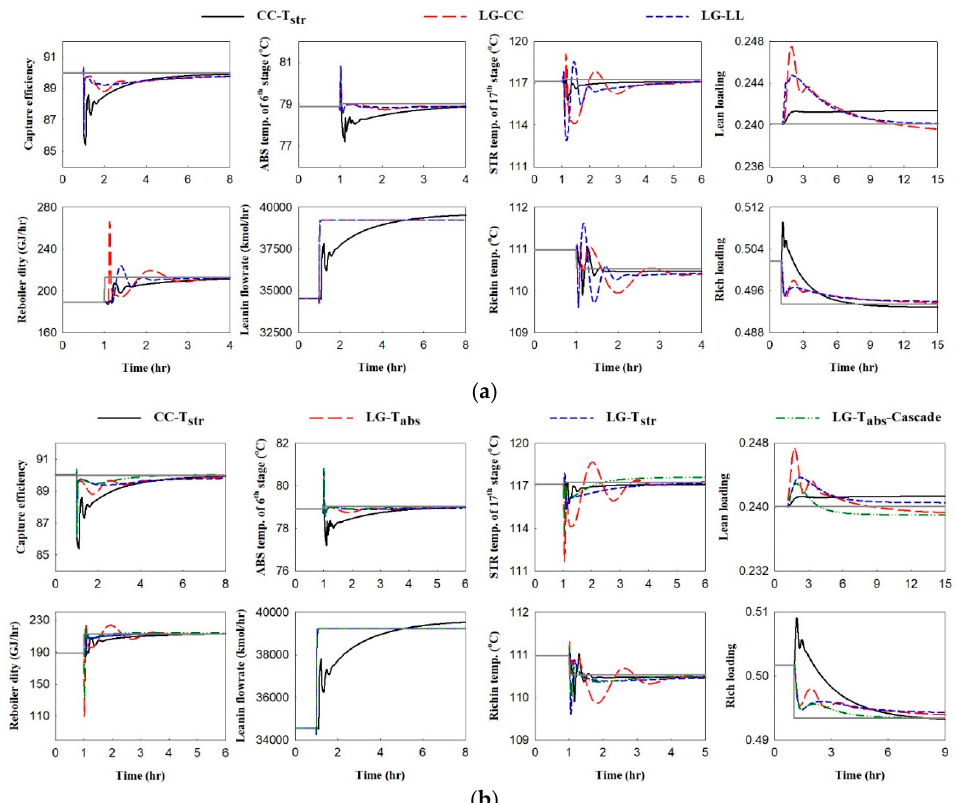
Figure 4. Dynamic responses for disturbance of flue gas flow rate with a 10% increase. The subfigures show the responses of the controlled variables (capture efficiency, lean loading, absorber temperature, and stripper temperature) and major process variables (lean solvent flow rate, reboiler duty, and the loading and temperature of the rich solvent). In both figures ( a , b ), the traditional control scheme (CC-T (cid:2929)(cid:2930)(cid:2928) ) responses are included for comparison. For all the control schemes, the original capture efficiency can be restored with the same reboiler duty at the new steady state. ( a ) concentration-control related schemes; ( b ) temperature-control related schemes.